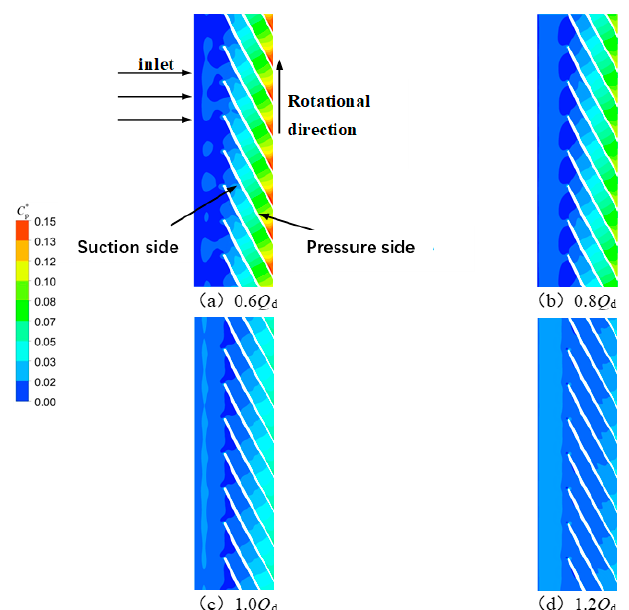
Figure 9. Blade to blade view of the pressure fluctuation intensity distribution of the first-stage impeller under di ff erent fl ow rates.